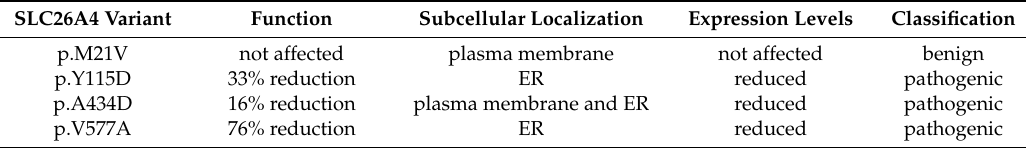
Table 3. Functional and molecular features of SLC26A4 variants.